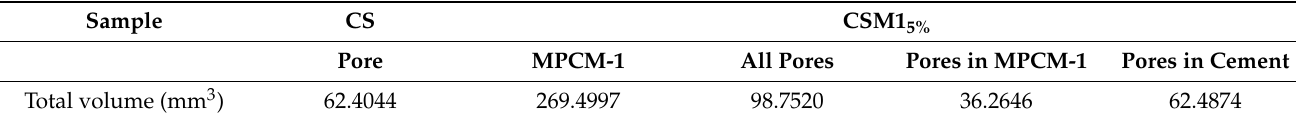
Figure 18. Slice images and 3D image model of the pores and MPCM-1 in CSM1 5% . Table 9. Total volume of MPCM-1, all pores, and the pores in